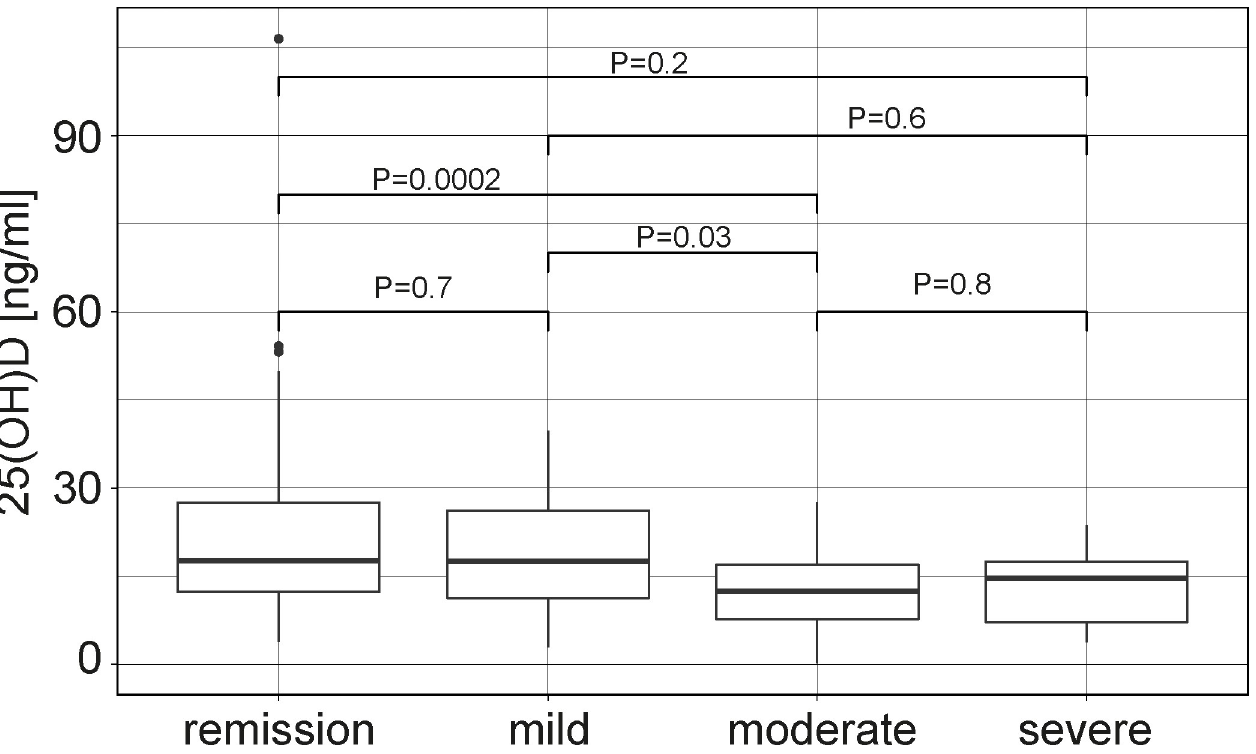
Fig 2. 25(OH)D serum concentrations correlate with CD activity. Disease activity was determined using the HBI (categorized as remission, mild, moderate or severe disease). Differences between groups were assessed using Kruskal Wallis test and Dunn’s post test and P values are indicated.